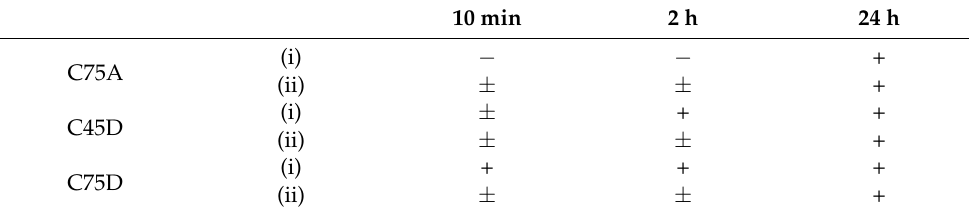
Table 3. Symbolic description of prostheses obtained for various times of the process ( n = 3).